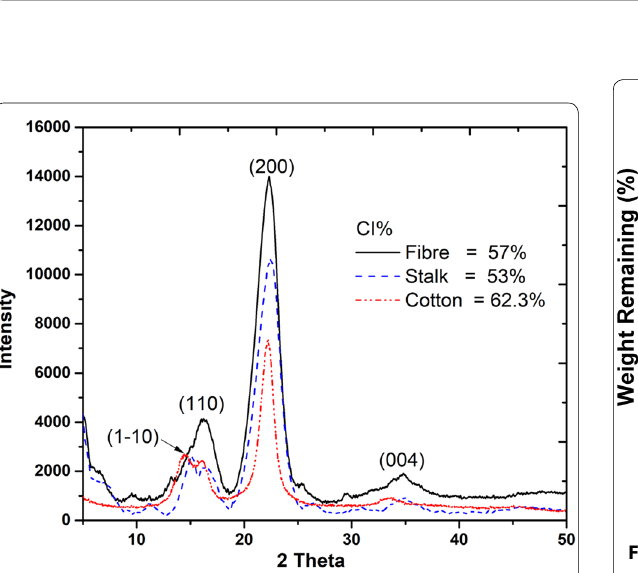
Fig. 2 X-ray diffractogram of M. pinnata stalk (before extraction) and extracted fibers compared with cotton fiber